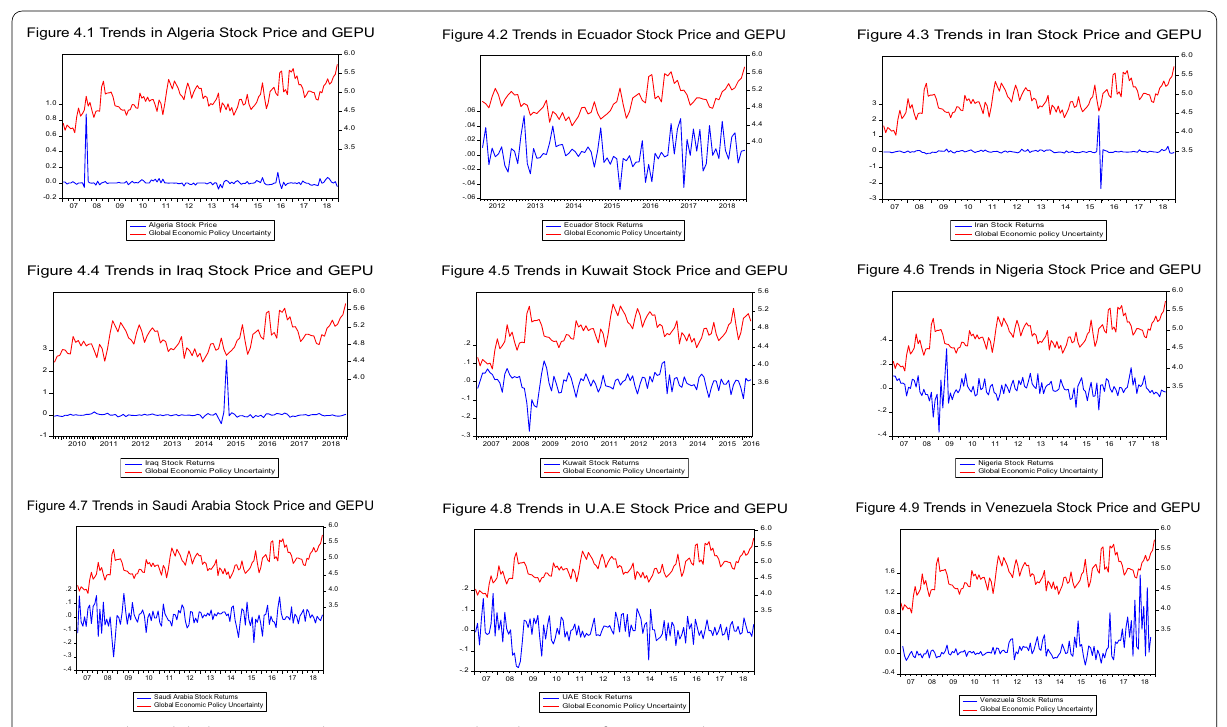
Fig. 1 Trends in global economic policy uncertainty and stock returns of OPEC